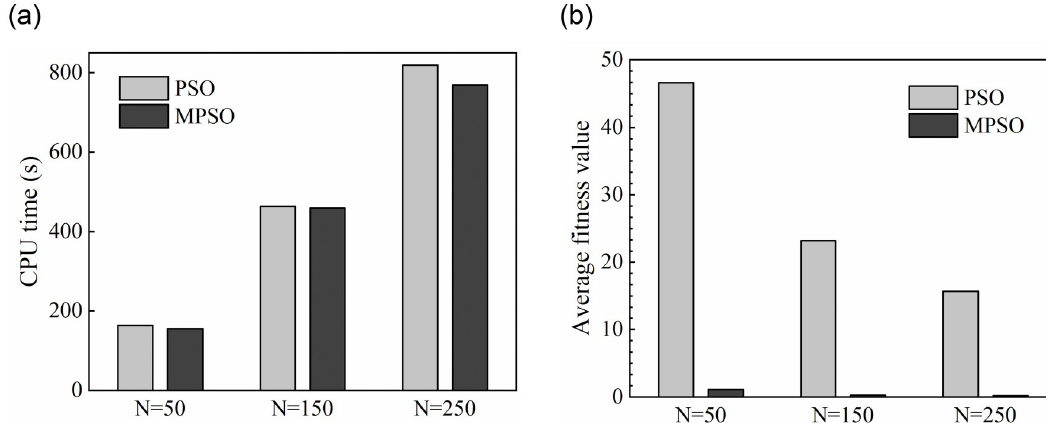
Fig 6. CPU time and average fitness value for two algorithms at the case of N = 50, 150 and 250. ( a ) CPU time. ( b ) Average fitness